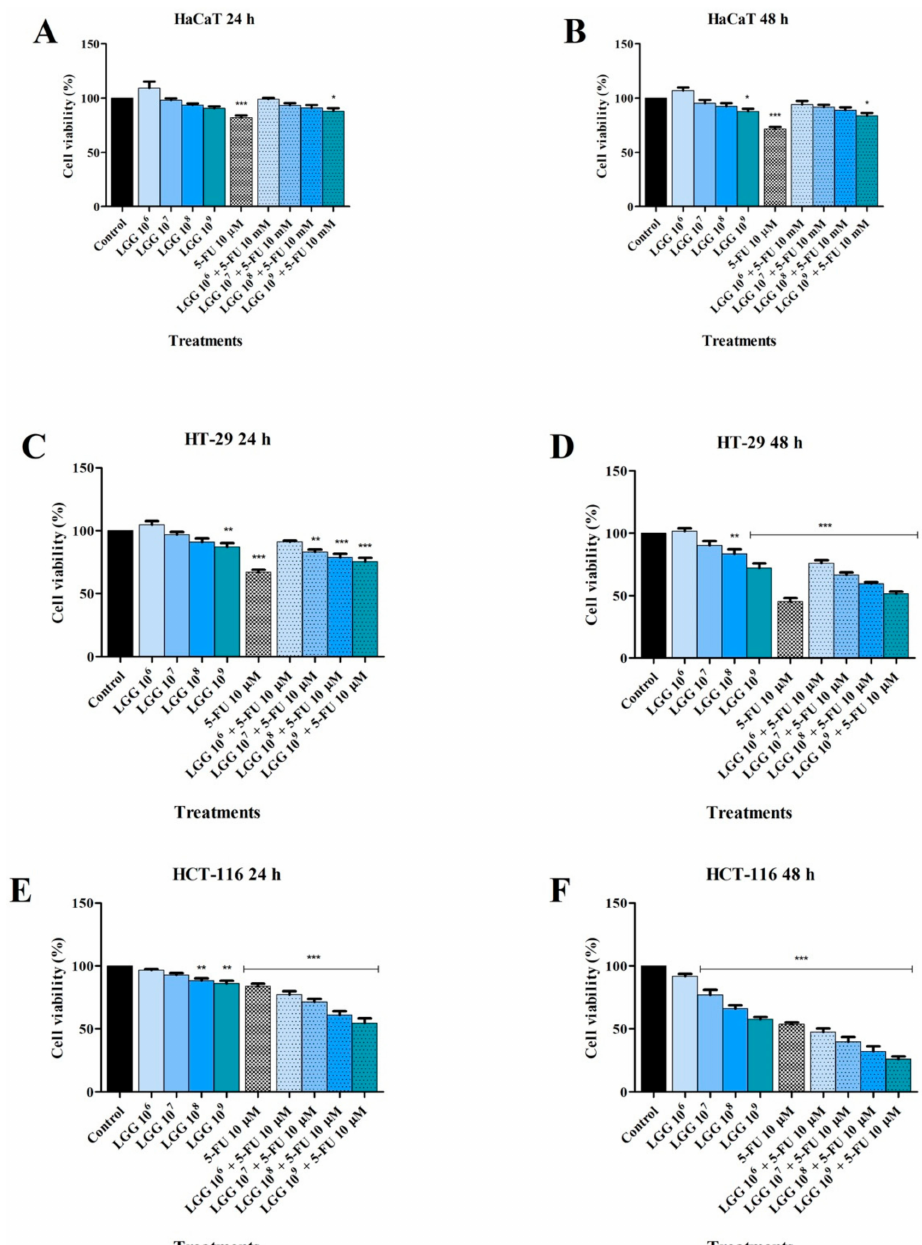
Figure 1. Cell viability of HaCaT ( A , B ), HT-29 ( C , D ) and HCT-116 ( E , F ) cells following the treatment with LGG 10 6 –10 9 CFU/mL, 5-FU (10 µ M), and their association after 24 and 48 h. The results are expressed as viability percentage in comparison with the control group, considered 100% (* p < 0.05, ** p < 0.01 and *** p < 0.001). The data represent the mean values ± SD of three independent experiments performed in